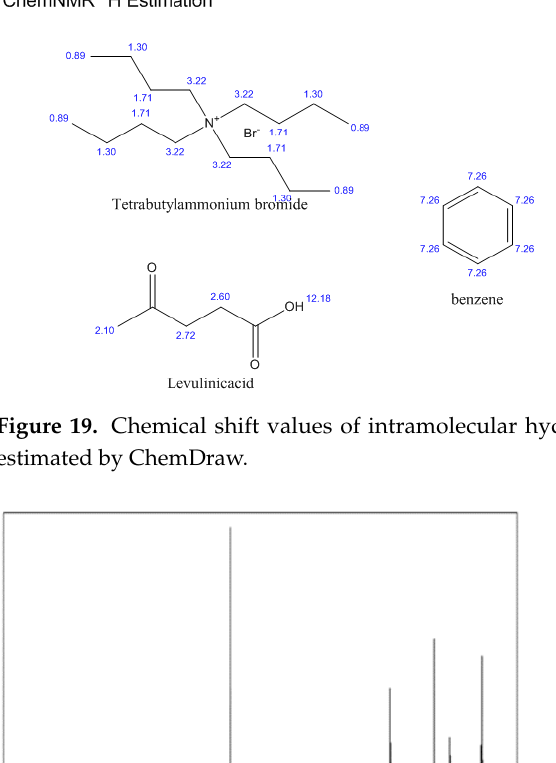
Figure 21. 1 H NMR of different molar ratios DES(1:2) and benzene (the DES mole concentrations are 1, 0.05, 0.1, 0.15, and 0.2 from the bottom up, respectively). Figure 22. A part of a larger view of Figure 21.